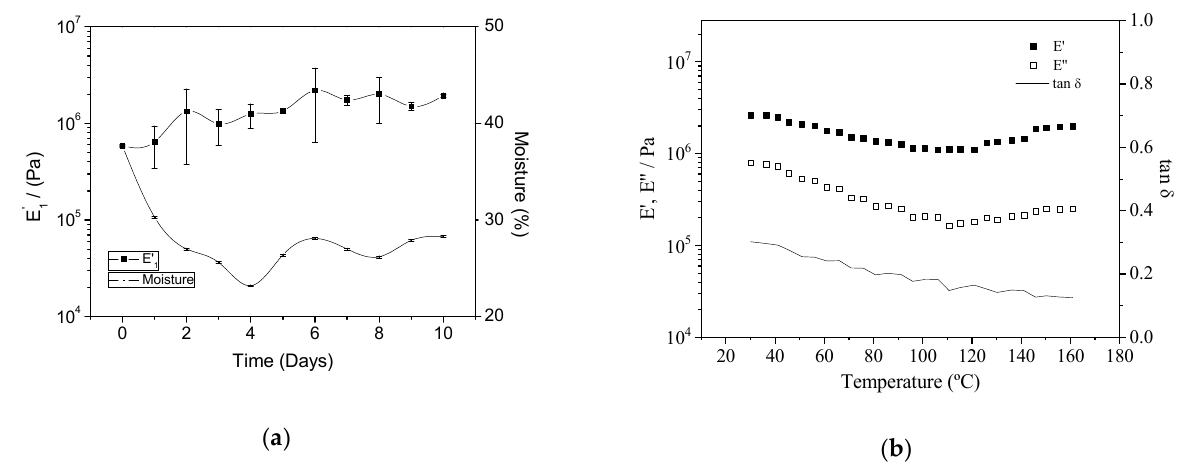
Figure 1. Viscoelastic properties at a constant frequency (1 Hz) of the doughs obtained after mixing. ( a ) Evolution of the elastic modulus (E′) and moisture content (%) over time. ( b ) Temperature sweep test of the stabilized dough between 30 and 160 ° C.